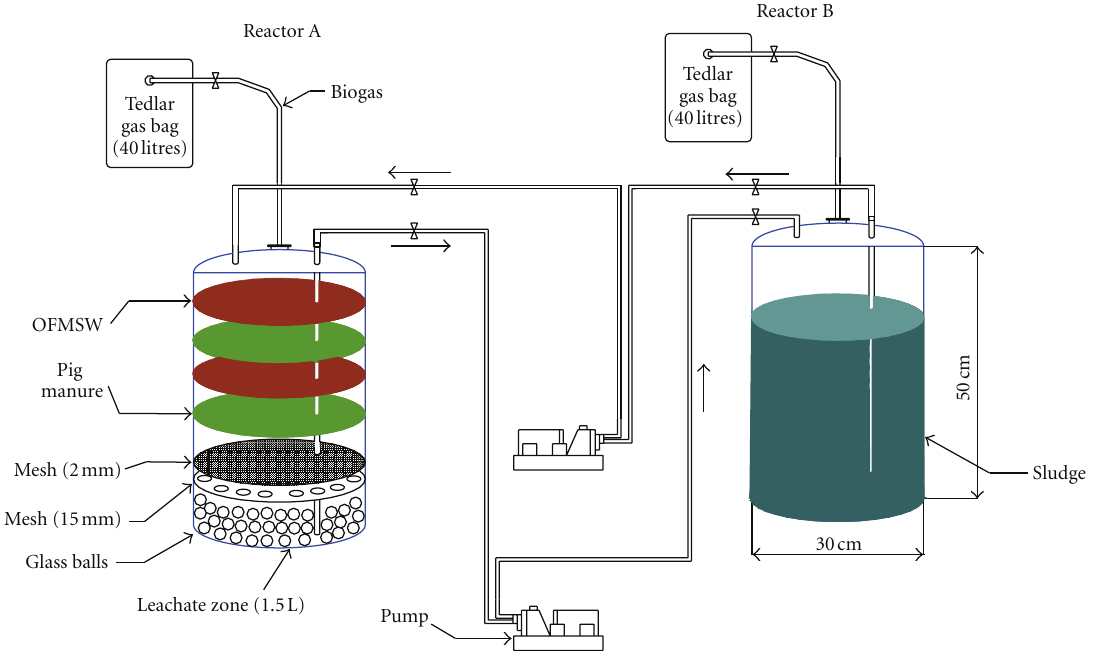
Figure 1: Flow of leachate in the modified SEBAC reactors.